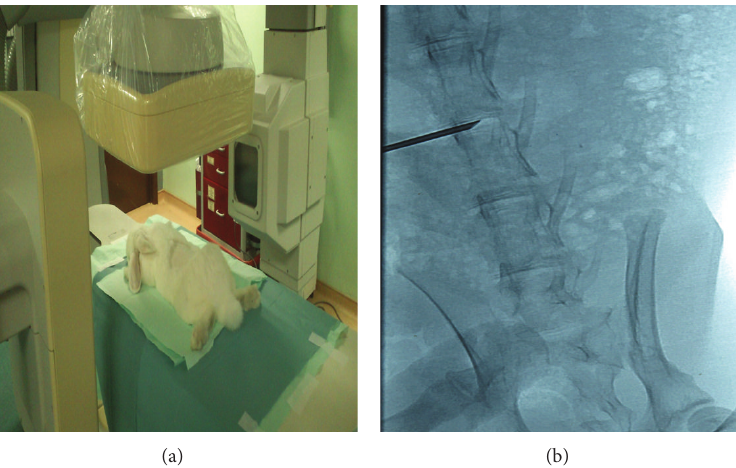
Figure 1: Rabbits placed under the fluoroscopy machine (a). Image captured after the disc damage was created at IVD L4/L5 (b).